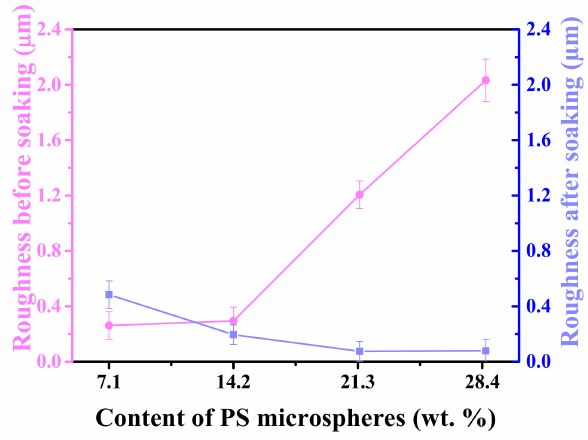
Figure 12. Roughness of PS-PEG hydrogels before and after swelling for 48 h.